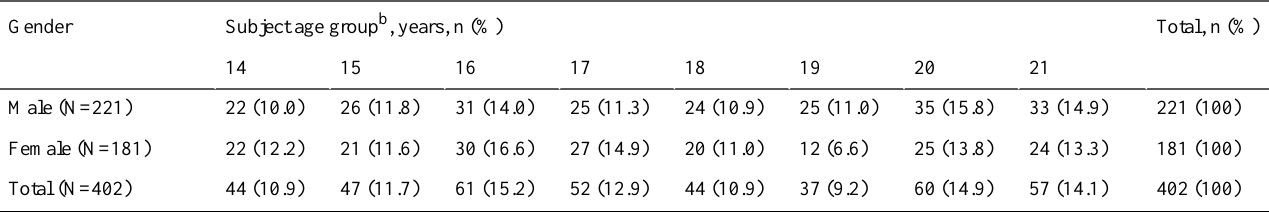
Table 1. Age distribution of the volunteer subjects a